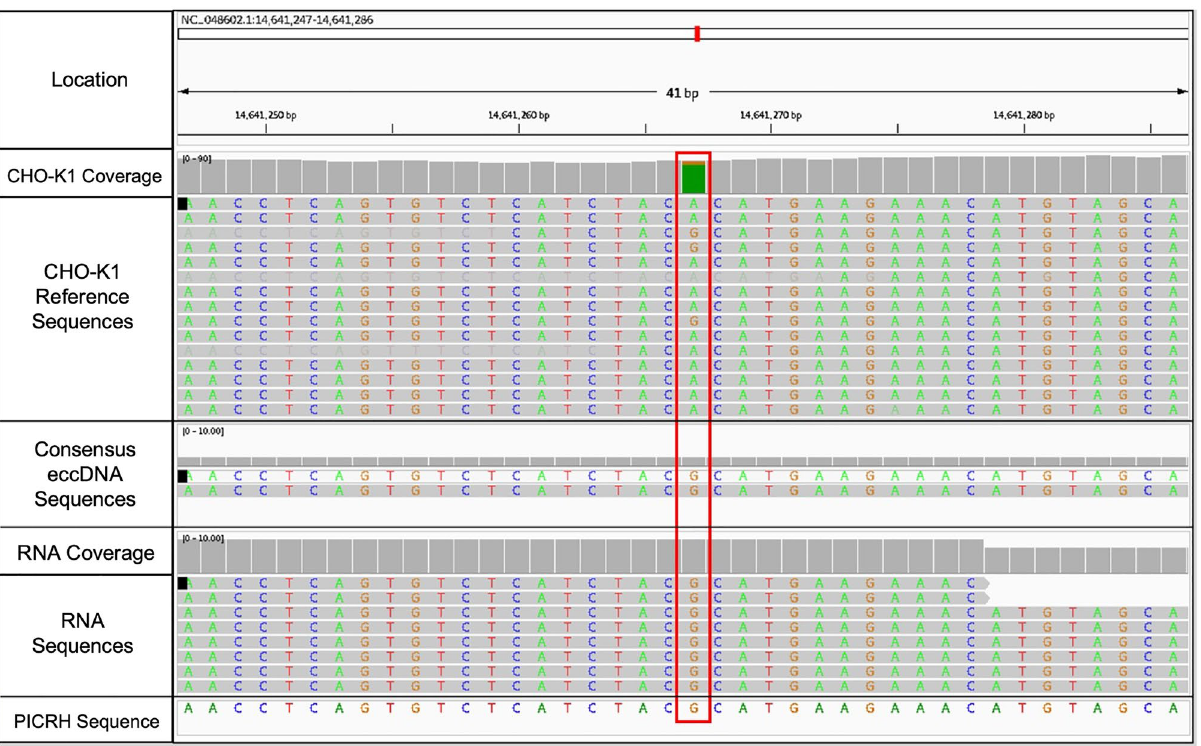
Figure 7. Example of transcripts with regions containing SNPs that may have originated from an eccDNA template on chromosome 9 at base 14,641,267. Rows from top to bottom are: location of the sequence, coverage of the CHO-K1 reference assembly, the CHO-K1 reference genome, consensus eccDNA sequence for the Lactate-stressed Day 12 samples, coverage of the RNA data, RNA transcripts for the Lactate-stressed Day 12 cultures, and the Chinese hamster PICRH reference genome. The height of the gray bars in the coverage row reflects the amount of coverage for each nucleotide. Colored bars in the coverage row reflect SNPs relative to the reference genome. Nucleotides are shown as: adenine (A)—green, thymine (T)—red, guanine (G)—orange, and cytosine